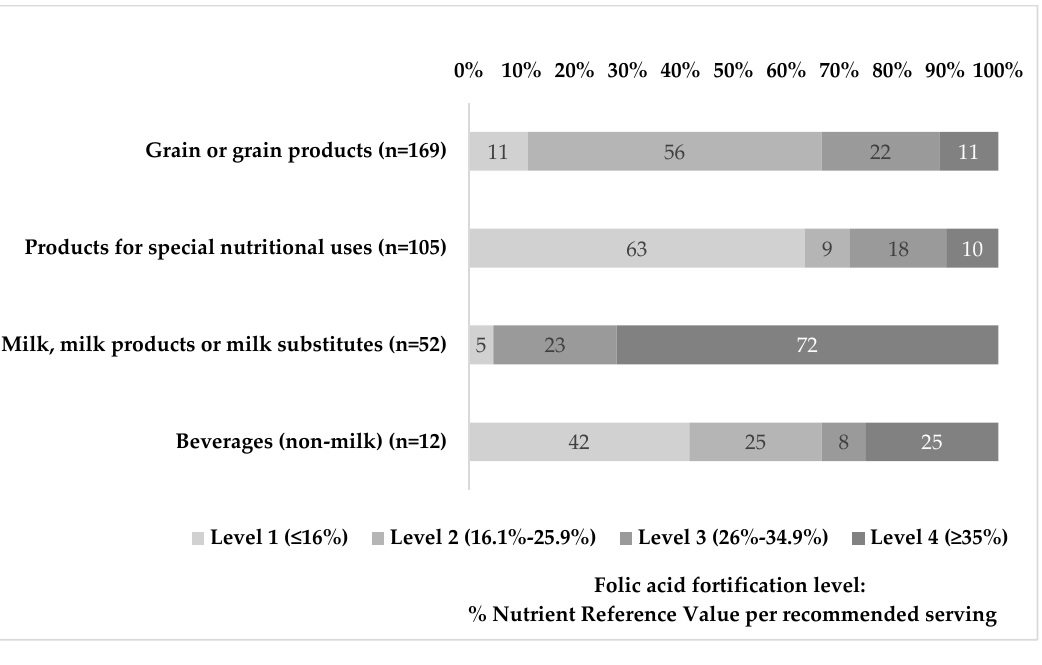
Figure 2. Folic acid fortification levels calculated per manufacturer’s recommended serving in compiled food groups from the Voluntary Folic Acid Fortification Food Composition Database.